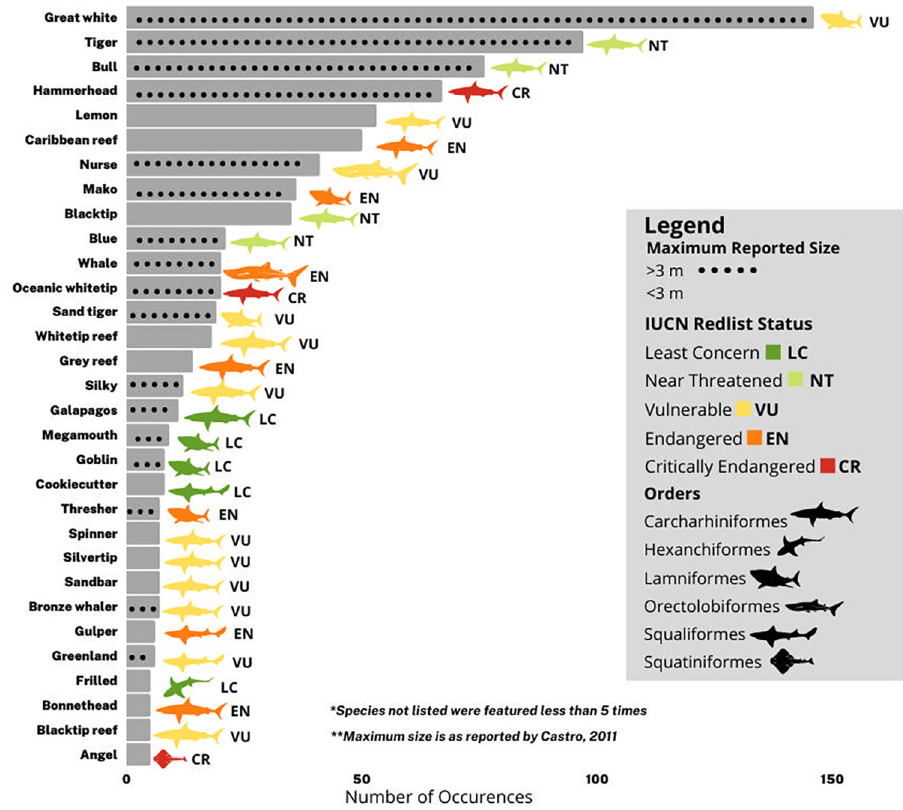
Fig 7. Species appearing in at least 5 Shark Week episodes. Hammerheads were most commonly great hammerheads S . mokarran , though scalloped hammerheads S . lewini and smooth hammerheads S . zygaena were sometimes mentioned. Conservation status reflects that of great and scalloped hammerheads (Critically Endangered); smooth hammerheads are currently assessed as Vulnerable. Mako sharks were almost always shortfin makos Isurus oxyrinchus , but one longfin mako I . paucus was mentioned (both species are